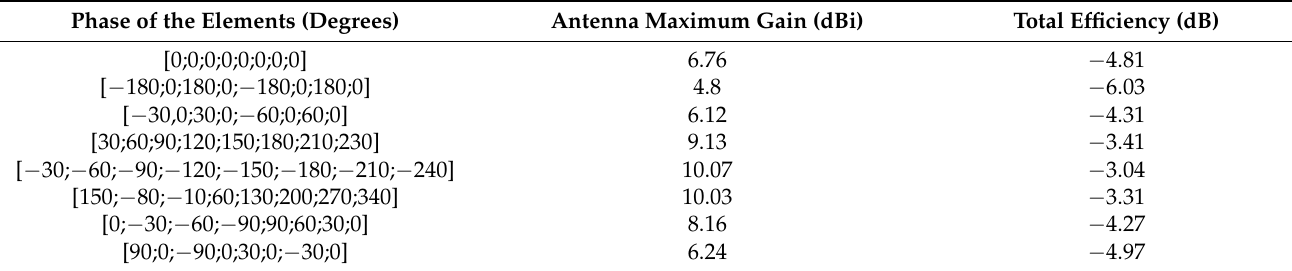
Table 2. The influence of the phase difference between the elements of planar array of 2 × 4 patch antenna on some significant